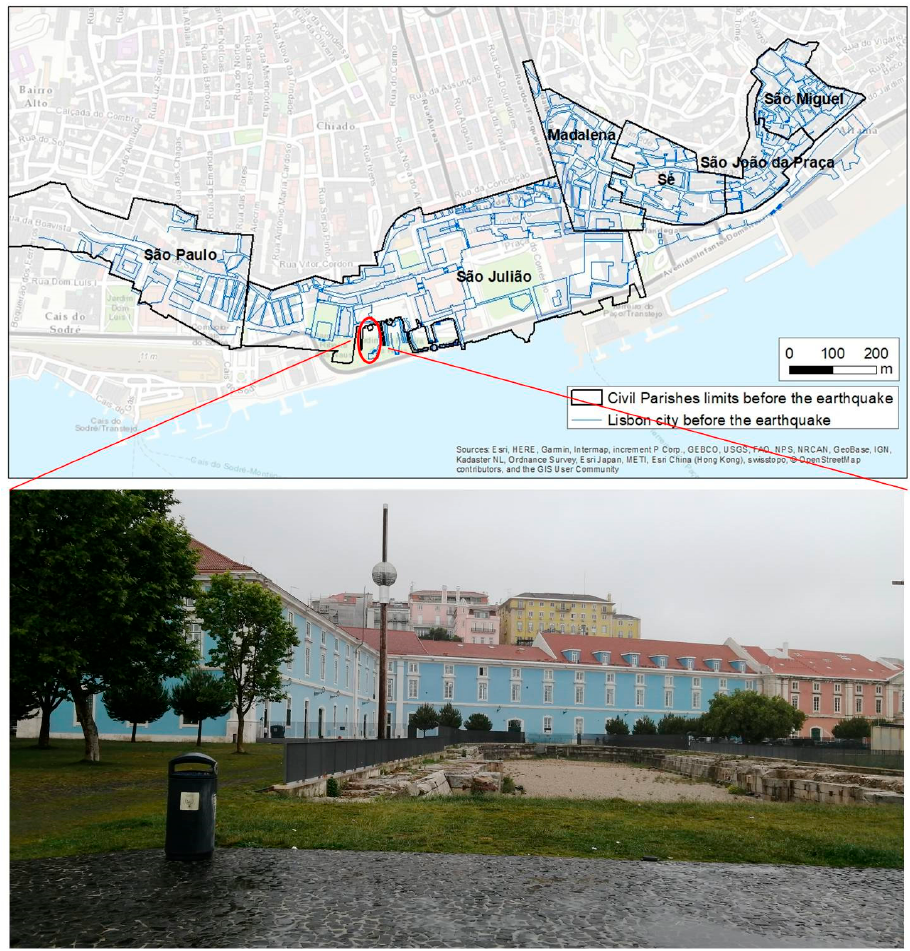
Figure 9. Upper plot: Lisbon city and the limits of the civil parishes, before the earthquake at the study area. These results are overlaid on the present day layout of the city. Lower plot: photo of the small marina that still exists today.